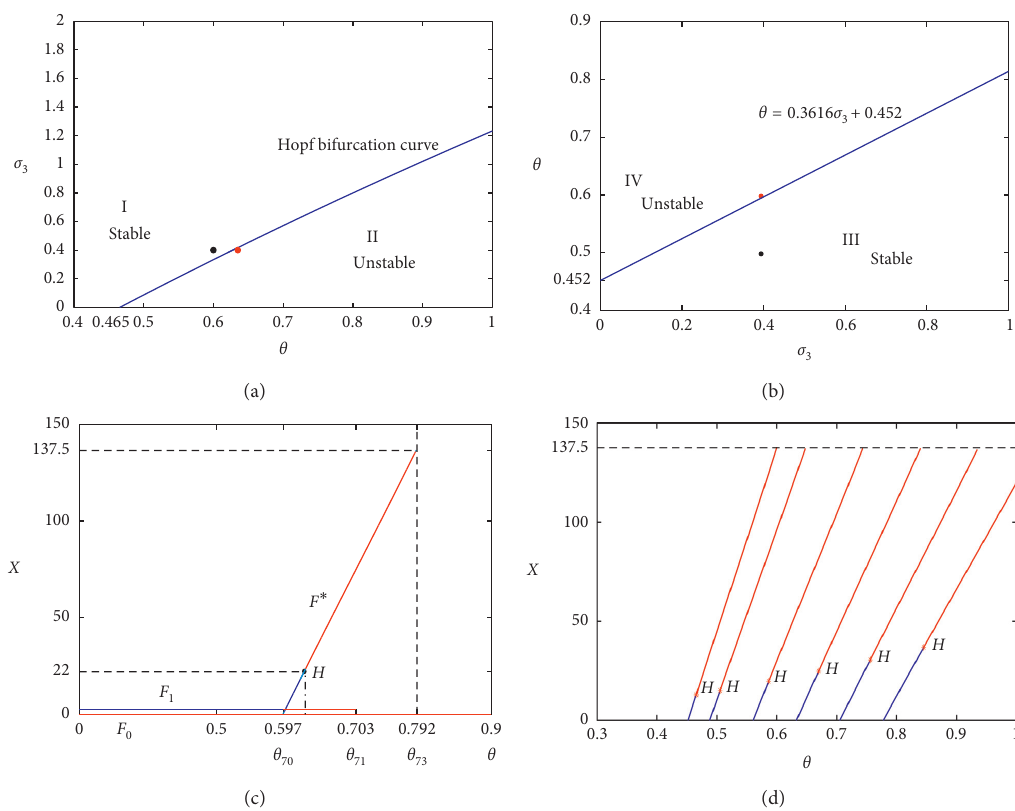
parameter plane. F ∗ is stable in region I and unstable in region II . 3 � 0 . 4. Hopf 3 � 0 , 0 . 1 , 0 . 3 , 0 . 5 , 0 . 7 , 0 . 9 (the 3